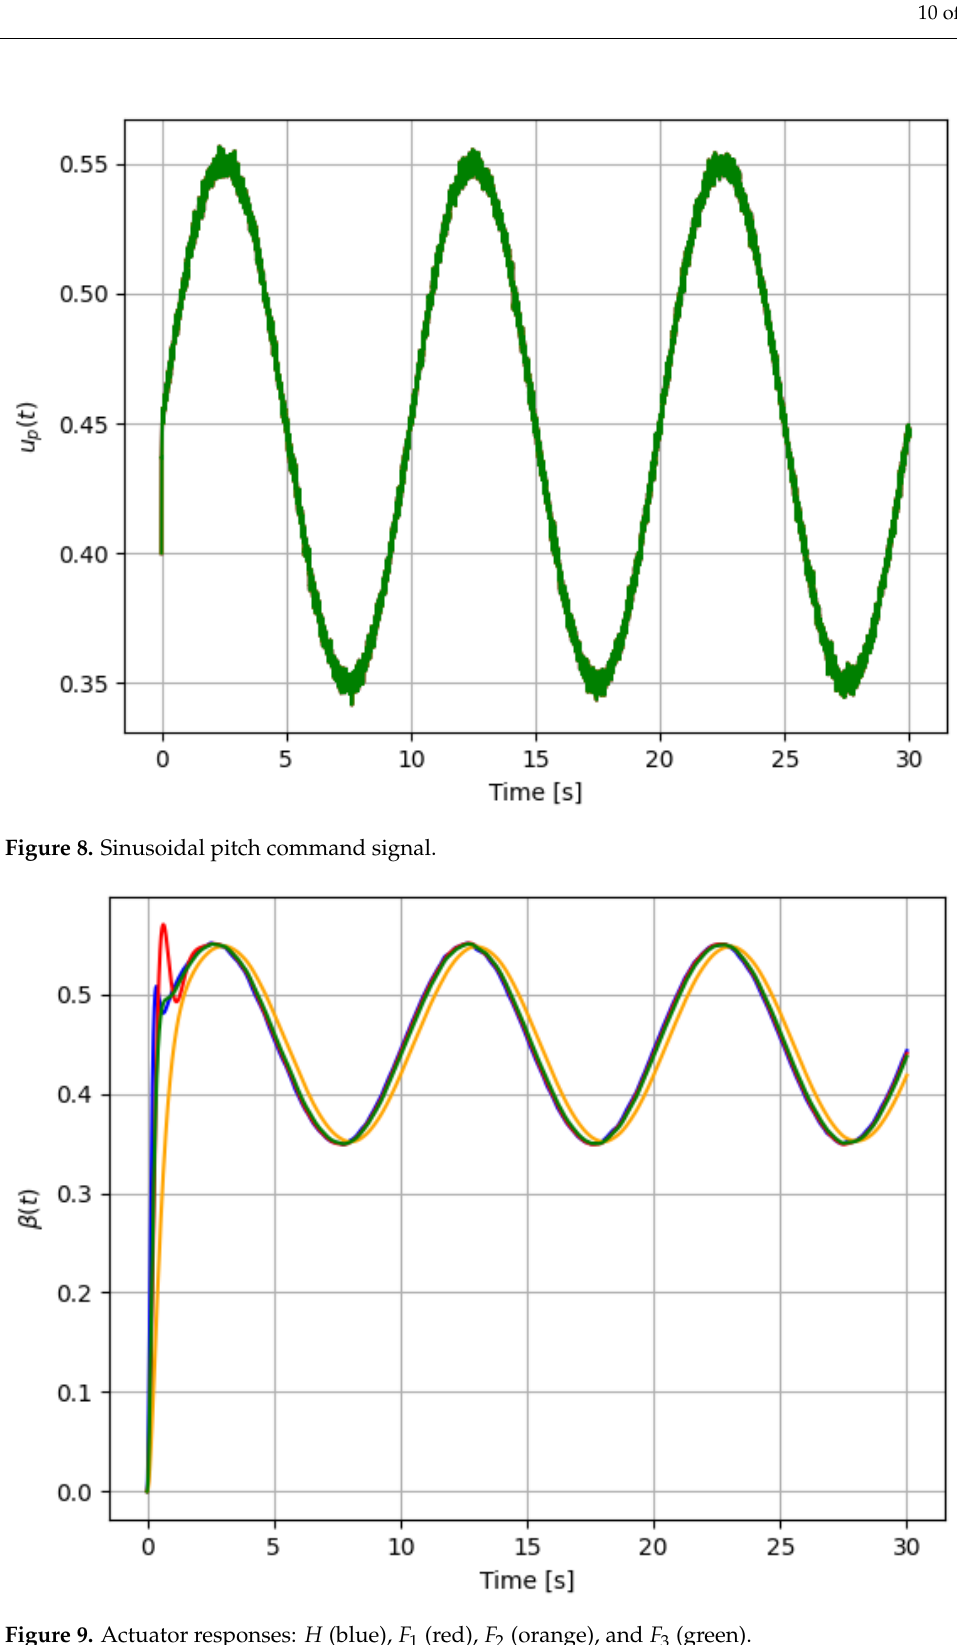
Figure 9. Actuator responses: H (blue), F 1 (red), F 2 (orange), and F 3